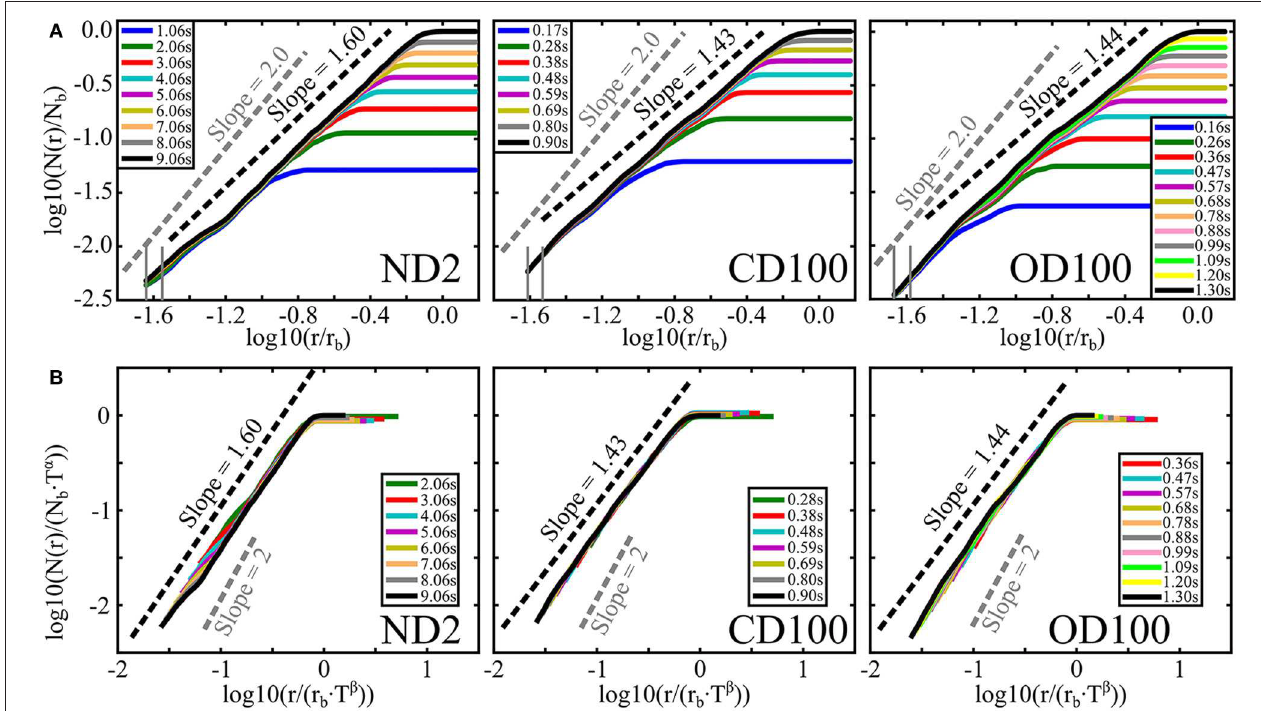
FIGURE 8 | (A) Examples of mass-radius relations at several snapshots for a non-deformable experiment at 25 hPa (left), a confined deformable experiment at 100 hPa (middle), and an open deformable experiment at 100 hPa (right). At the start of the curves, the leftmost gray vertical lines mark the lower radius cutoff, which is just outside the injection region, and the gray vertical lines to the right mark a distance of 1 mm outside the lower cutoff. The black dotted lines show the estimated mass dimensions for the breakthrough patterns. The gray dotted lines has slopes of 2 to indicate the space filling dimension of an emptied bubble. (B) Family-Vicsek scaling of the same mass-radius relations as above, except for the smallest clusters with a total mass < 10% of the breakthrough mass. On the axes, T = ( t / t b ) is the ratio of time over breakthrough time, r is radius, r b is breakthrough radius, N ( r ) is mass within radius r , N b is total mass at breakthrough, and α and β are scaling exponents. Here, for ND2: α = 1.45 and β = 0.80, for CD100: α = 1.58 and β = 1.02, and for OD100: α = 1.73 and β = 1.10.